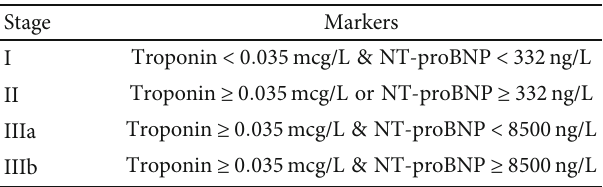
Table 1: Cut-o ff values for NT-proBNP and troponin based on the European modi fi cation of the Mayo 2004 staging for prognosticating AL